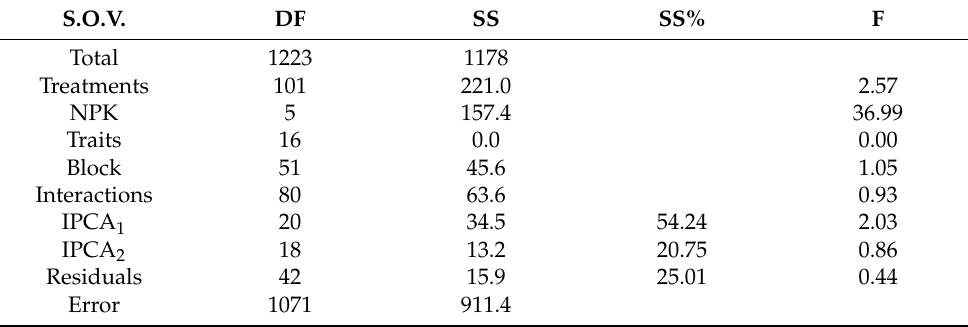
Table 3. Variance analysis by AMMI model FAO410 in six NPK treatments.